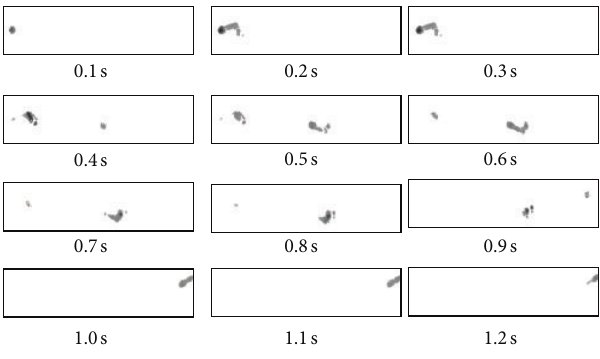
2.3. Data Set. From the acquired sole pressure data, the system separates a right sole pressure data and a left sole pressure data. We define sole coordinate system as shown